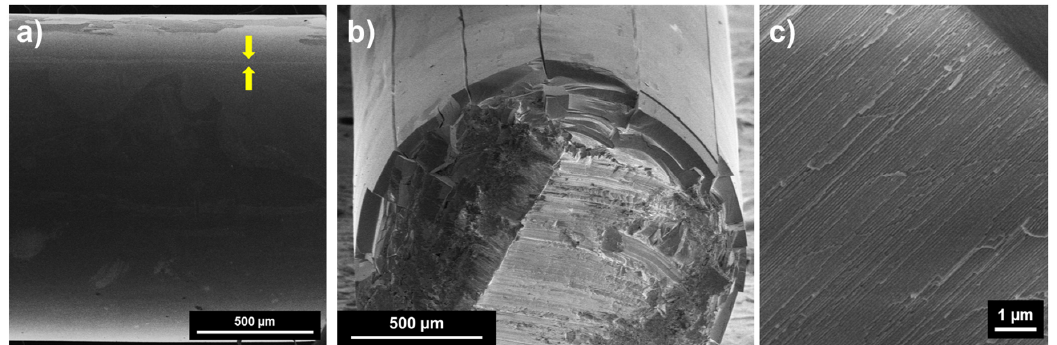
Figure 2. ( a ) Surface of the wire after electropolishing. Yellow arrows point to a die line. ( b ) A cross ‐ sectional view of the obtained CPAA after first anodization, where no hard anodization pulses were applied. ( c ) Detailed view of the CPAA shown in (b).